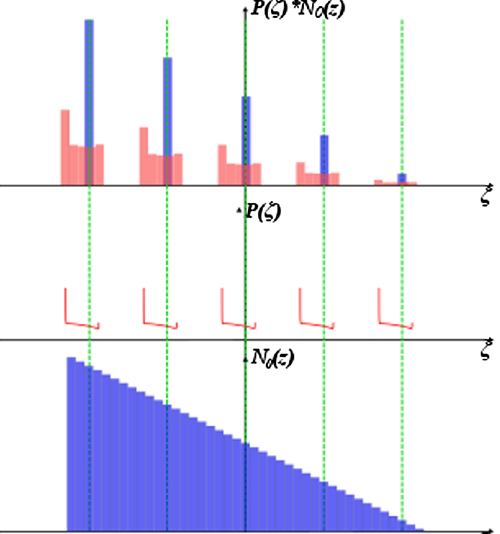
FIG. 18. The CSR perturbation. Bottom: The ideal n 0 ð z i f Þ profile. Middle: The perturbation function P ð ζ Þ . Top: Slices of the ideal profile n 0 ð z i f Þ (blue) and the perturbed profile n ð z p f Þ (red). The CSR perturbation has skewed-Gaussian-like spread with spikes at each end, and it is the same for all